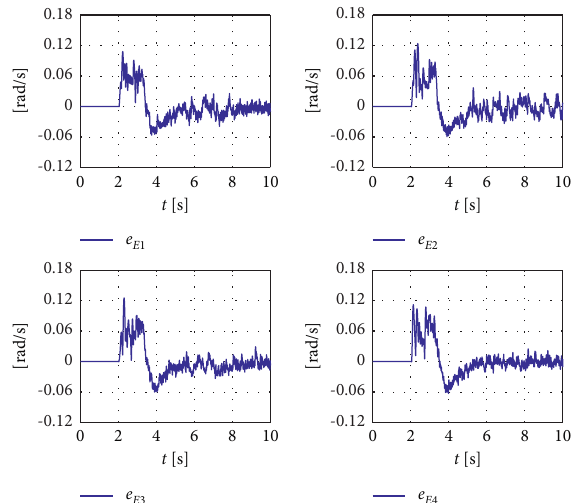
Figure 16: Angular velocity tracking errors obtained from the experimental results shown in Figures 12–15 when abrupt variations are considered in parameters R and C of the DC/DC Buck converter and E ( t ) emulates a renewable energy power supply. The plotted results associated with eE 1 and eE 2 are achieved when the experimental implementation of E ( t ) (equation (24)) is programmed through the TDK- Lambda G100-17 power supply, while the plotted results related to eE 3 and eE 4 are obtained when the experimental implementation of E ( t ) (equation (25)) is realized via the solar panel TS-S425 of the TDK-Lambda G100-17 power